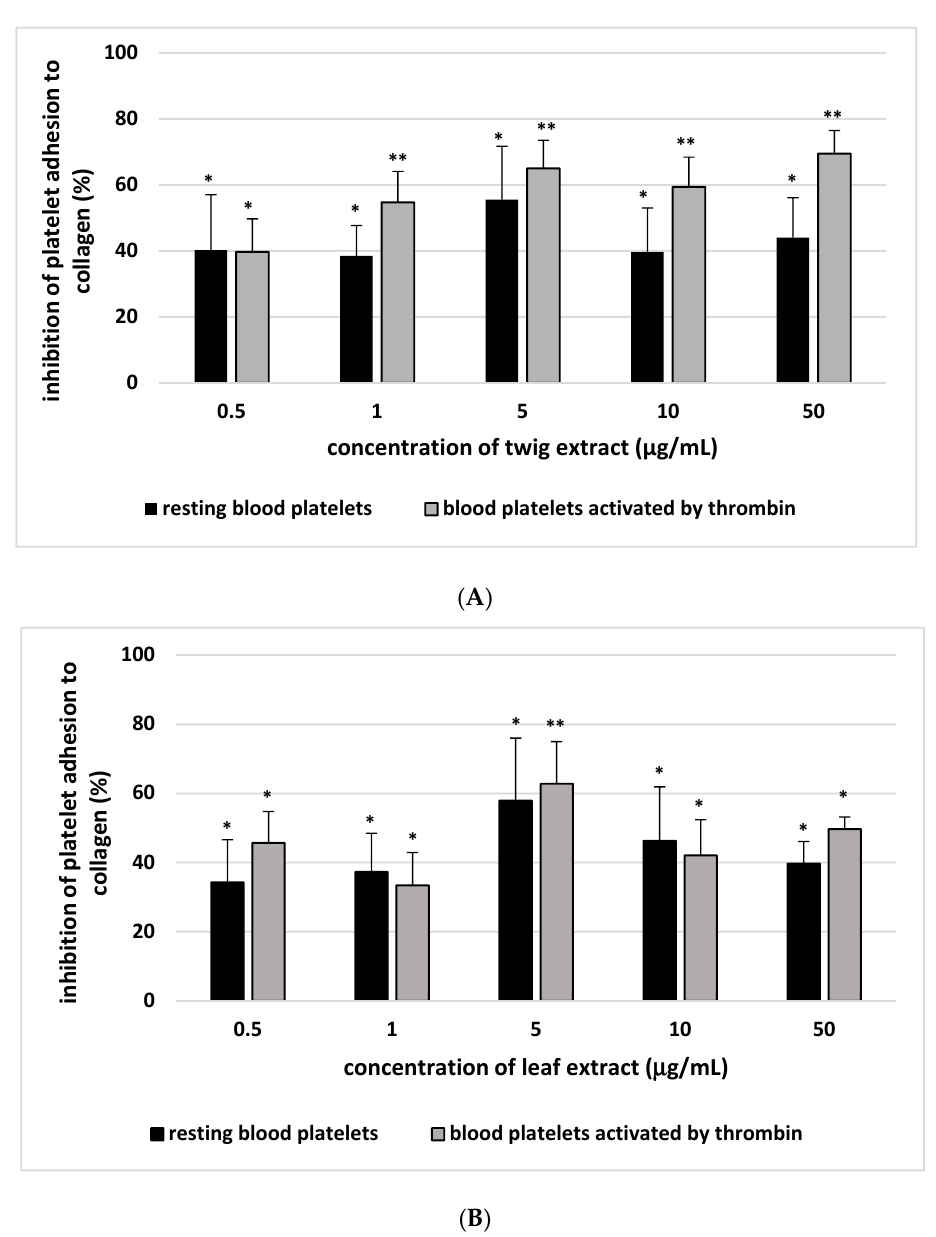
Figure 1. Twig (A) and leaf extract (B) (0.5–50 µg/mL; 30 min) on adhesion of resting blood platelets and thrombin-activated platelets to collagen. The inhibition of platelet adhesion by the plant extracts is expressed as the percentage of that recorded for control blood platelets (without the plant extract) – positive control. Data represent mean ± standard error (SE) of 5 (for resting platelets) and 9 (for thrombin-activated platelets) healthy volunteers (each experiment performed in triplicate). * p < 0.05, ** p < 0.02 (vs. control platelets).